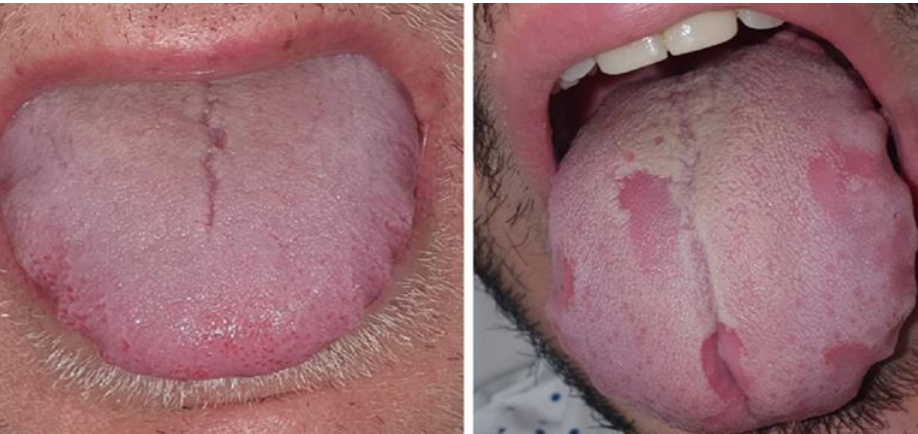
Figure 4. Macroglossia with lateral indentations ( left ) geographic tongue ( right ) (Reprinted with permission from ref. [79] . Copyright Year (2020); Copyright Owner (John Wiley and Sons).